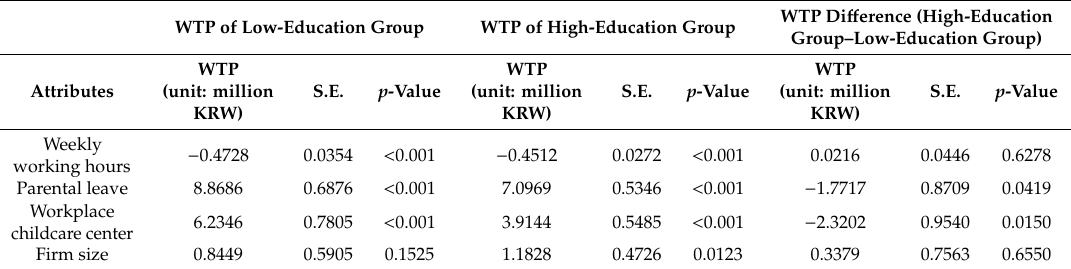
Table 10. WTP for workplace attributes, by level of